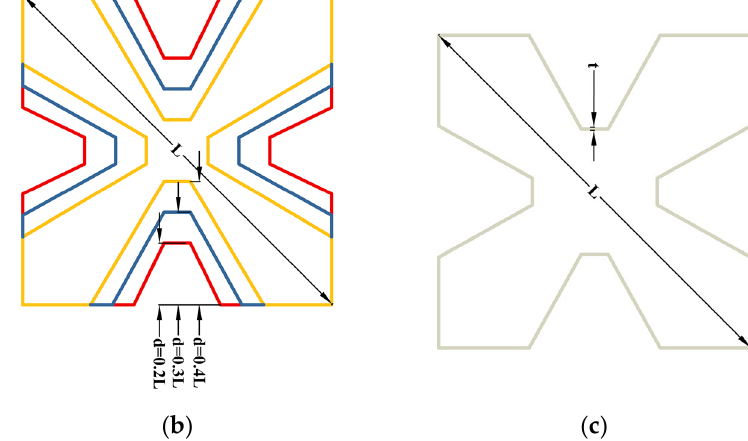
Figure 10. Mechanical properties of compliant lattice with different S-shaped bulge widths and beam section sizes: ( a ) The relationship between the elastic modulus and the cube side length (W = 0.05–0.09 L); ( b ) The relationship between the Poisson’s ratio and the cube side length (W = 0.05– 0.09 L); ( c ) The relationship between the elastic modulus and the cube side length (t = 0.5–4.5 mm); and ( d ) The relationship between the Poisson’s ratio and the cube side length (t = 0.5–4.5 mm).